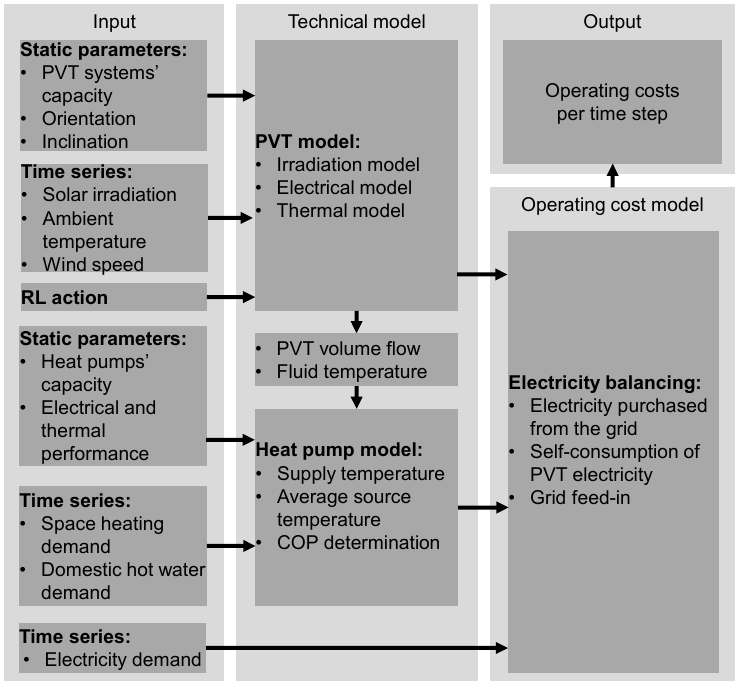
Figure 2. Overall energy system model consisting of the technical model with a PVT model and a heat pump model as well as the operating cost model .